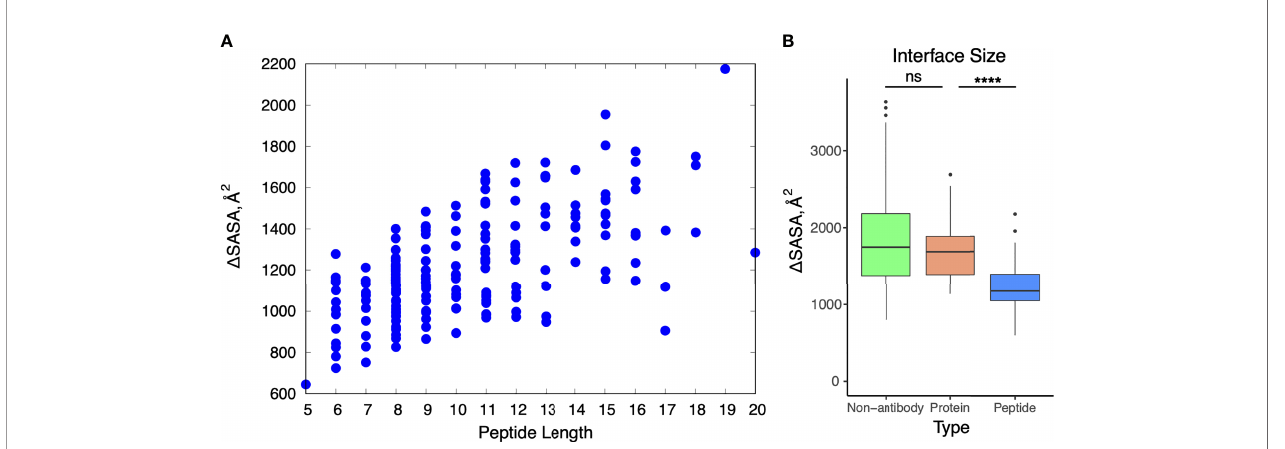
FIGURE 3 | Buried solvent accessible surface area in antibody-peptide interfaces. (A) Change in accessible surface area ( D SASA) for antibody-peptide interactions in comparison with length of the peptide (in residues) in the structure. (B) Change in accessible surface area for non-antibody-antigen (N = 190), antibody-protein (N = 54), and antibody-peptide (N = 188) interfaces. Non-antibody-antigen and antibody-protein complex structures are nonredundant sets previously reported in Protein Docking Benchmark 5.5 (7). Statistical signi fi cance tests between sets of values were calculated with Wilcoxon rank sum test (ns: p > 0.05; ****: p ≤ 0.0001). Two outlier points for the non-antibody-antigen set with very high D SASA values (6671 Å 2 , 6628 Å 2 ) are not shown.